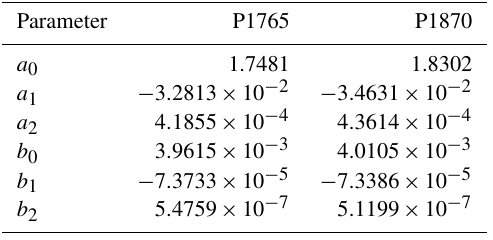
Table 4. Fitted parameters in Eqs. (2) and (3) for the perturbation simulations P1765 and